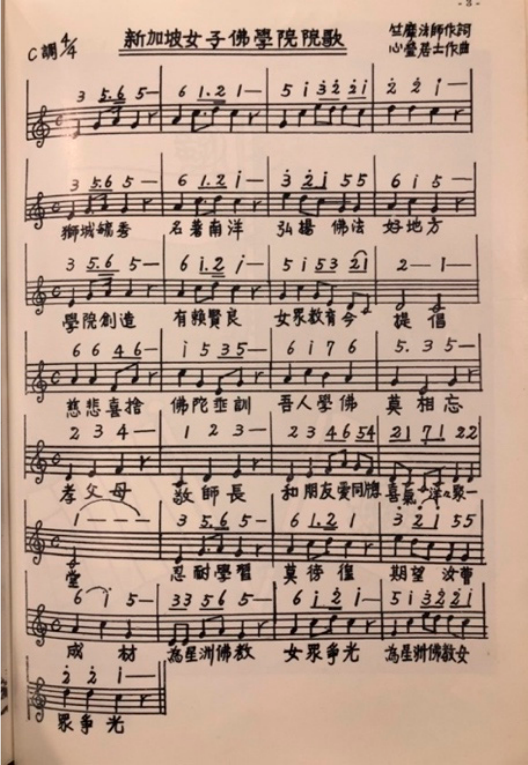
Figure 2. The school anthem of the Singapore Girls’ Buddhist Institution 12 .